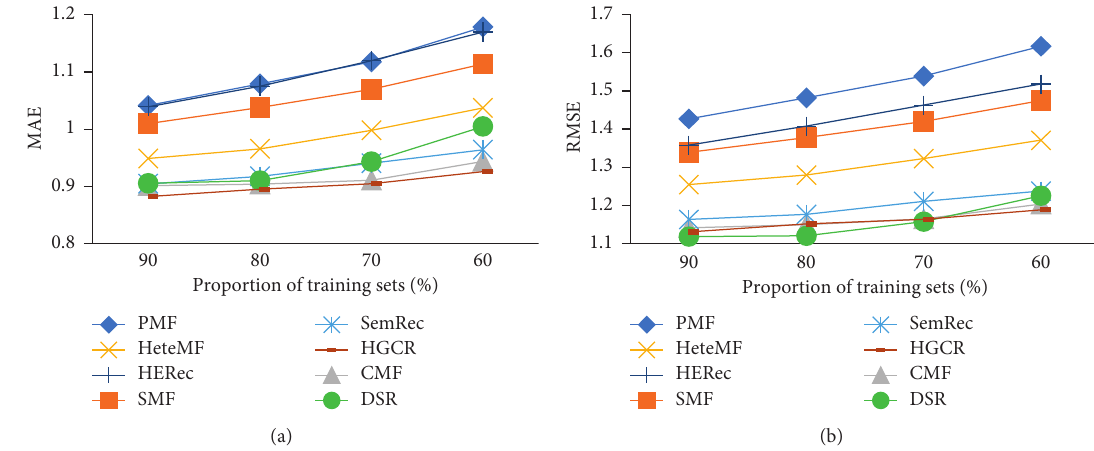
Figure 6: Performance of Yelp with different Algorithms. (a) MAE vs. proportion of training sets. (b) RMSE vs. proportion of training